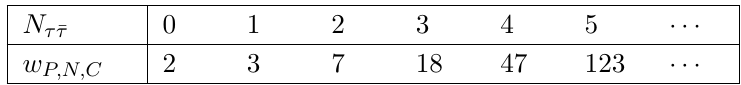
Table 2 . State counting of (cid:28) (cid:22) (cid:28) on a